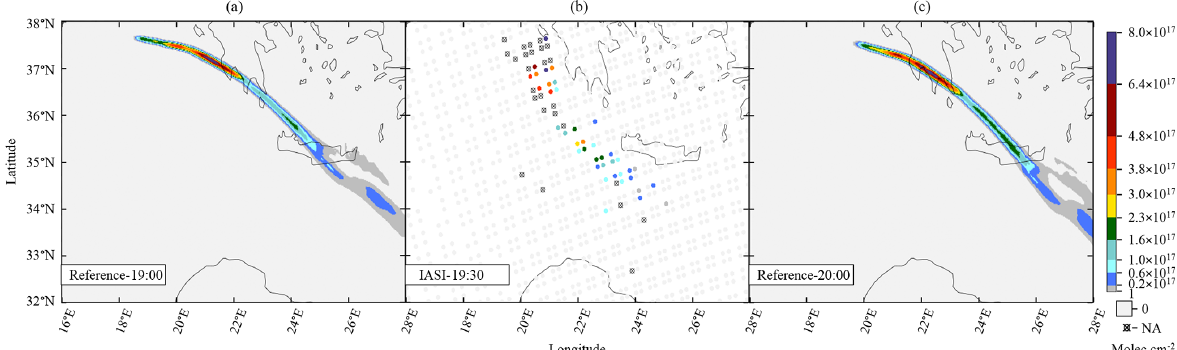
Figure 1. Columns of SO 2 from CHIMERE simulations and IASI measurements. Unavailable IASI data are shown as crossed circles. Null values are shown in light grey. The IASI sounding corresponds to 19:30UTC (b) . The CHIMERE Reference simulation is displayed for 19:00UTC (a) and 20:00UTC (c)